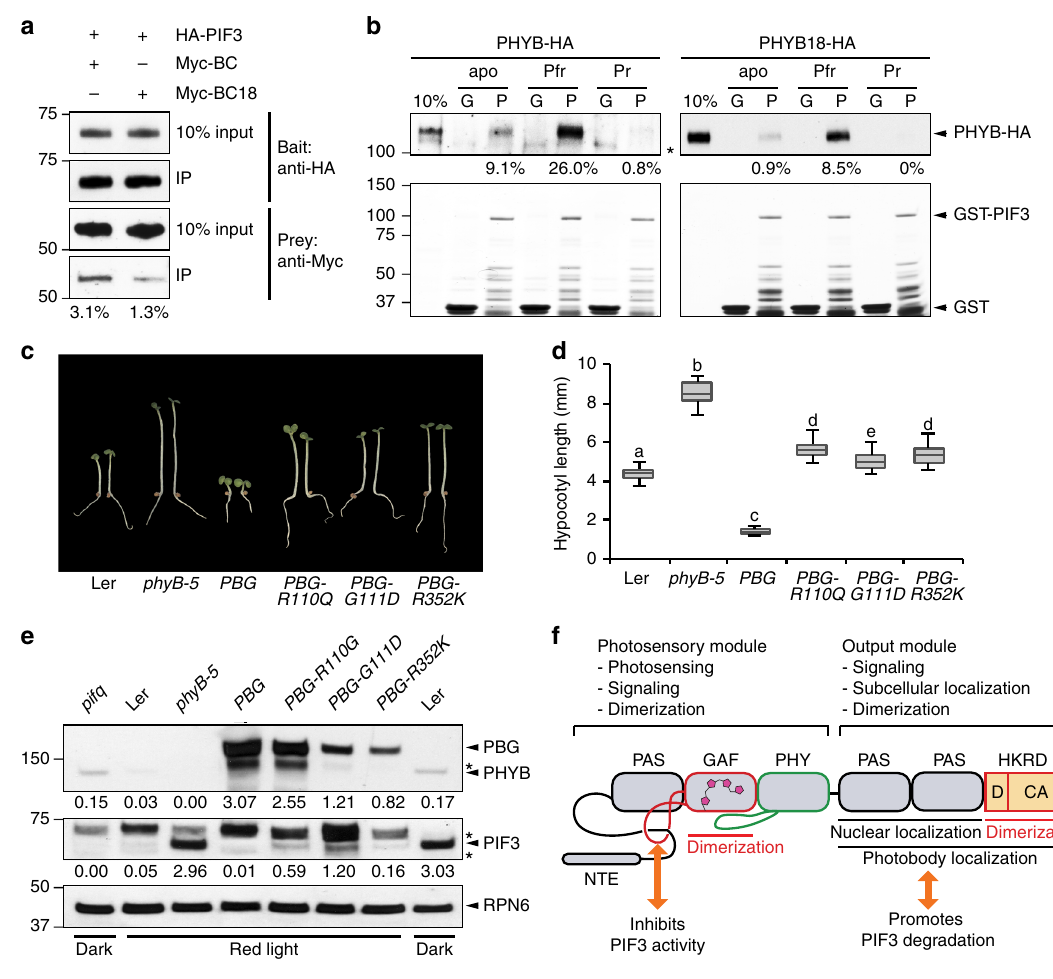
Fig. 8 The C-terminus of PHYB is a signaling-output module for PIF3 degradation. a In vitro co-immunoprecipitation experiments showing that the D1040V mutation disrupts the interaction between the C-terminal module of PHYB (BC) and PIF3. HA-tagged PIFs (HA-PIF3) and Myc-tagged C-terminal domain of PHYB or PHYB18, Myc-BC or Myc-BC18, were co-translated in vitro. HA-PIF3 was pulled down by anti-HA af fi nity matrix. The input and bound HA-PIF3, Myc-BC, and Myc-BC18 were detected by immunoblots using either anti-HA or anti-Myc antibodies. The estimated bound fractions of Myc-BC and Myc-BC18 are shown below the anti-Myc blots. b GST pull-down assays using GST-PIF3 to pull down PHYB-HA and PHYB18-HA in apoprotein, Pr, or Pfr forms. The upper panels are immunoblots using anti-HA antibodies showing bound and input fractions of PHYB-HA or PHYB18-HA. The lower panels are Coomassie Blue-stained gels showing immobilized GST and GST-PIF3. The estimated bound fractions of PHYB-HA or PHYB18-HA for each pulldown assays are shown below the blots. G, GST; P, GST-PIF3. The asterisk indicates nonspeci fi c bands. c Images of 4-day-old Ler, phyB-5 , PBG , PBG-R110Q , PBG-G111D in c . Samples with different letters indicate statistically signi fi cant differences in hypocotyl length (ANOVA, Tukey ’ s HSD, P < 0.05, n > 40). e Immunoblots showing the levels of PHYB and PIF3 in 4-day-old Ler, phyB-5 , PBG , PBG-R110Q , PBG-G111D , and PBG-R352K lines grown in 10 μ mol m − 2 s − 1 R light. Dark- grown pifq samples were used as negative controls for the PIF3 immunoblots. RPN6 was used as a loading control. The relative levels of PHYB and PIF3 were normalized against the corresponding levels of RPN6 and are shown below the blots. Asterisks indicate nonspeci fi c bands. f Model for the structure- function relationship of Arabidopsis PHYB. The N-terminal photosensory module of PHYB is responsible for light sensing through the bilin chromophore in the GAF domain and subsequent conformational changes of the tongue (green loop). Photoactivation of the N-terminal module induces an Pfr-speci fi c interaction between the knot lasso and PIF3, this interaction contributes to light signaling by repressing the transcriptional activity of PIF3. The GAF domain provides a dimerization interface within the N-terminal module. The C-terminal output module of PHYB interacts directly with PIF3 to mediate its degradation. The PRD is responsible for mediating the nuclear accumulation of PHYB and the entire C-terminal module is required for photobody localization. The entire HKRD provides another dimerization domain. The HKRD communicates with the PRD to facilitate PHYB nuclear accumulation. Dimerization of the HKRD is required for both nuclear and photobody localization of PHYB. The domain structure of PHYB is modi fi ed from Burgie